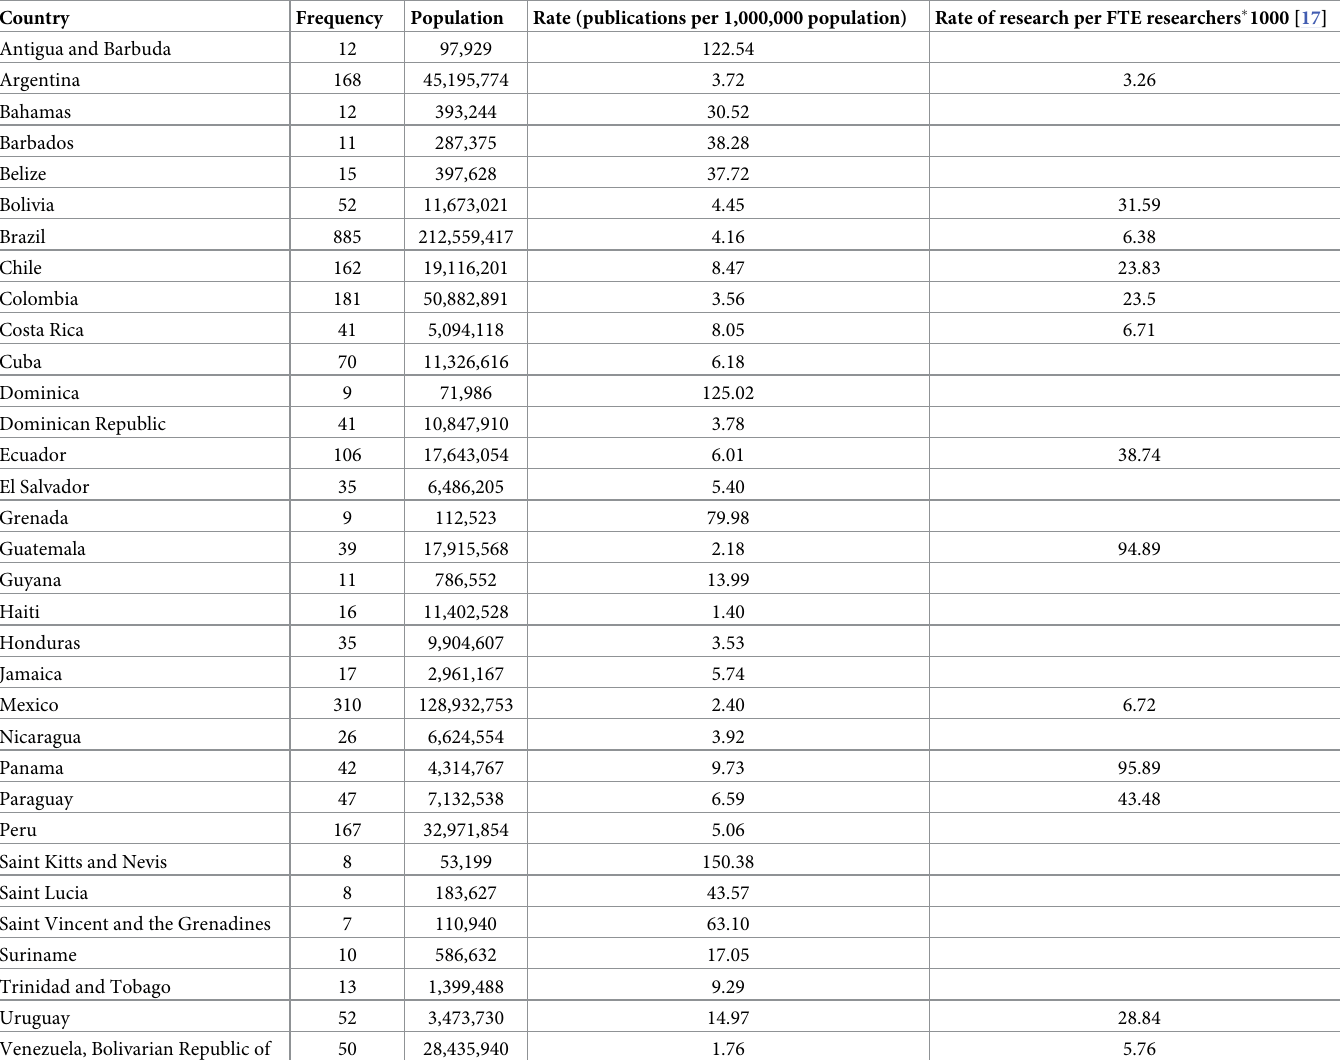
Table 1. Empirical studies related to COVID-19 in each LAC